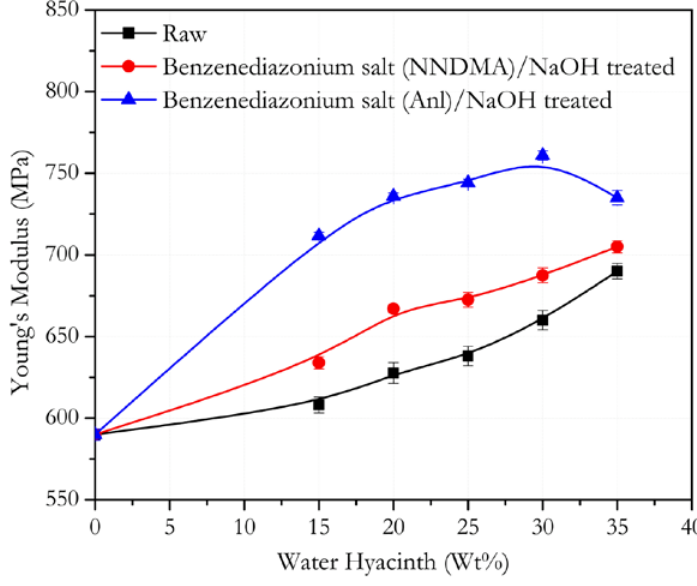
Figure 4: Effect of fiber loading on the Young’s modulus of WH-PP composites